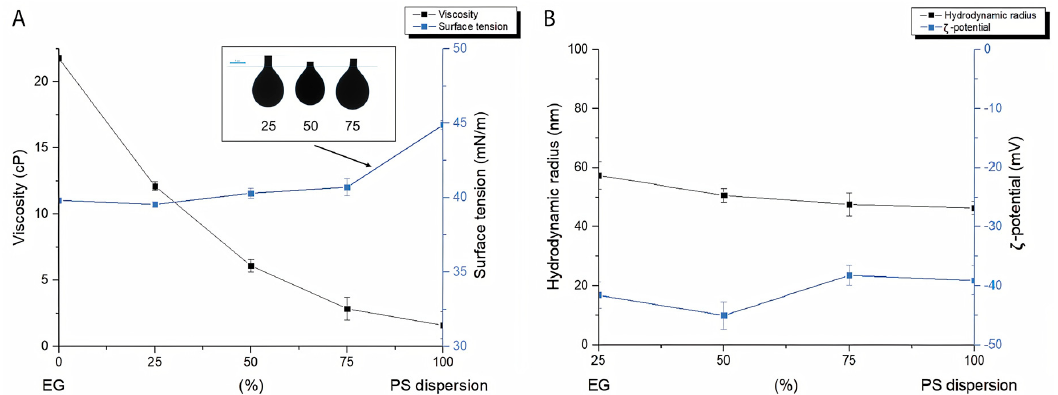
Figure 2. Rheological parameters for inks with different ratios of polystyrene spheres (PSS)/ethylene glycol (EG): ( A ) dual system diagram (PS, EG) describing the relationship between the percentages of components and parameters such as viscosity and surface tension; ( B ) dual system diagram (PS, EG) describing the relationship between the percentages of components and parameters such as hydrodynamic radius and ζ -potential.